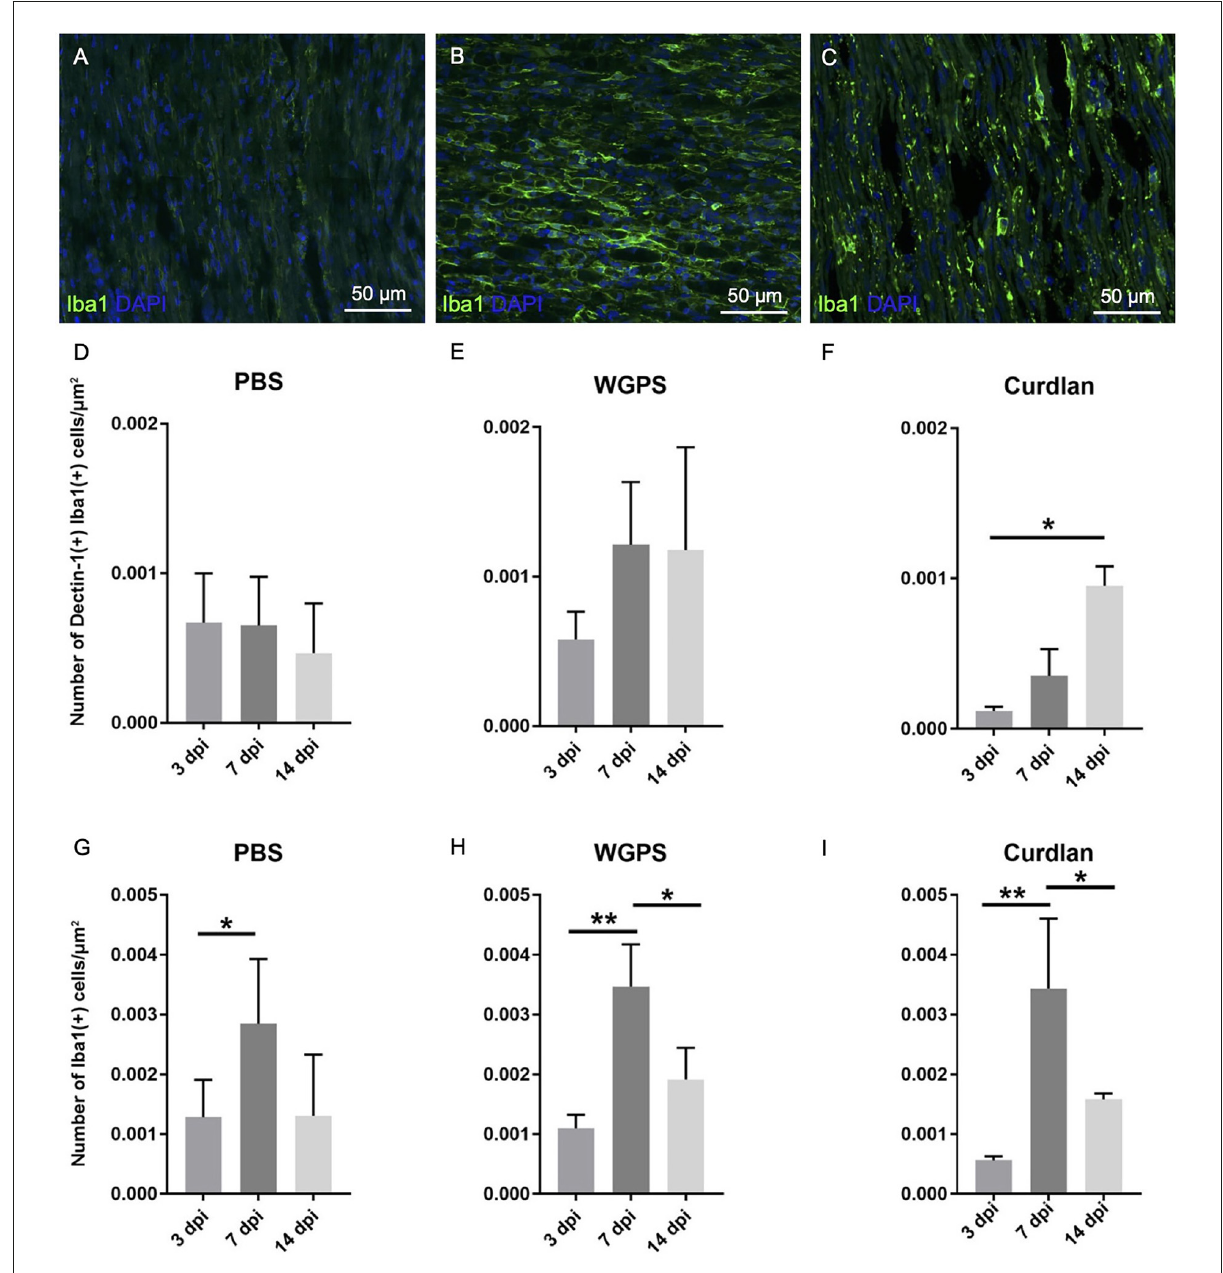
FIGURE8 Analysis of Dectin-1 and Iba1 colocalization or Iba1 expression on crushed sciatic nerves. Longitudinal sections of the ipsilateral sciatic nerve from 500 µ m proximal to 500 µ m distal to the crushed site were stained with anti-Dectin-1 and anti-Iba1 antibodies or anti-Iba1 antibody only. Dectin-1(+) Iba1(+) cells or Iba1(+) cells were identified for analysis. (A–C) Representative figures from (A) crushing injury plus PBS injection 3 days after injury, (B) crushing injury plus PBS injection 7 days after injury, (C) crushing injury plus PBS injection 14 days after injury. (D–F) Quantitative analysis of Dectin-1(+) macrophage density [Dectin-1(+)/Iba1(+) cell density] at different time points. (G–I) Quantitative analysis of macrophage density [Iba1(+) cell density] at different time points. Macrophage density was significantly higher at 7 days after injury in the PBS, WGPS, and curdlan groups; there was no difference between Dectin-1 macrophage densities in the PBS and WGPS groups at different time points. There was increased Dectin-1 macrophage density in the curdlan group at 14 days compared with 3 days after injury. Data are represented as mean ± SD ( n : 3 dpi: PBS = 4, WGPS = 3, curdlan = 4; 7 dpi: PBS = 5, WGPS = 3, curdlan = 3; 14 dpi: PBS = 3, WGPS = 3, curdlan = 3). ** p < 0.01, * p < 0.05.